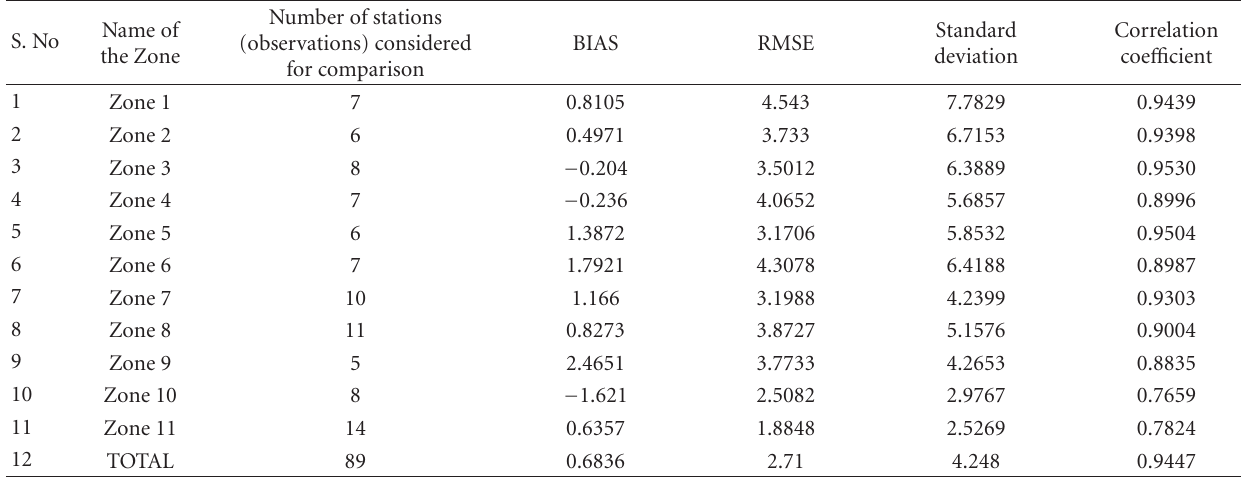
Table 2: Number of the station observations considered for the average surrounded by the corresponding zones and the correlation coe ffi cient values between the areas averaged daily mean temperatures at 2m height from model and station observations. S.